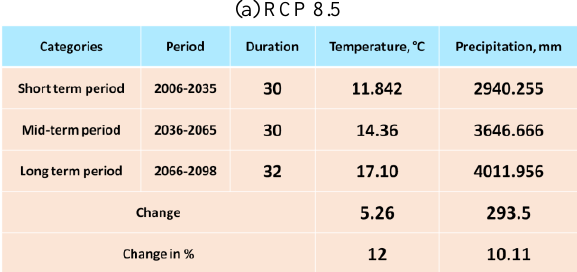
Table 1. The change in temperature and precipitation